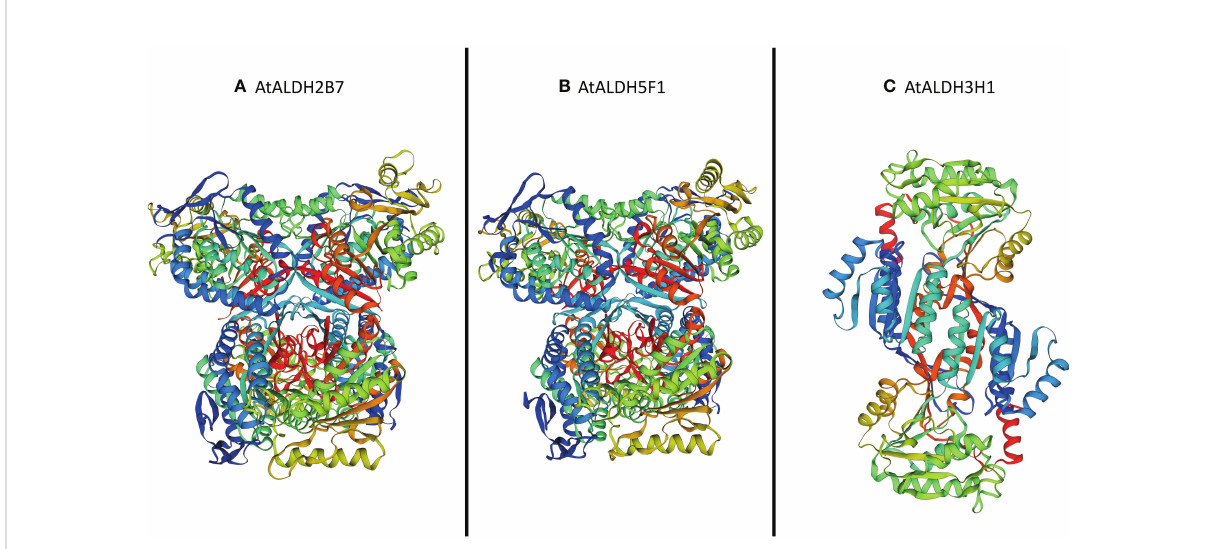
FIGURE 12 Three-dimensional structure analysis of the proteins encoded by three hypoxia responsive AtALDH genes. (A) AtALDH2B7; (B) AtALDH5F1; and (C) AtALDH3H1. All the structures were visualized by rainbow color from N to C terminus. Coils and smooths represent alpha helices and beta sheets,